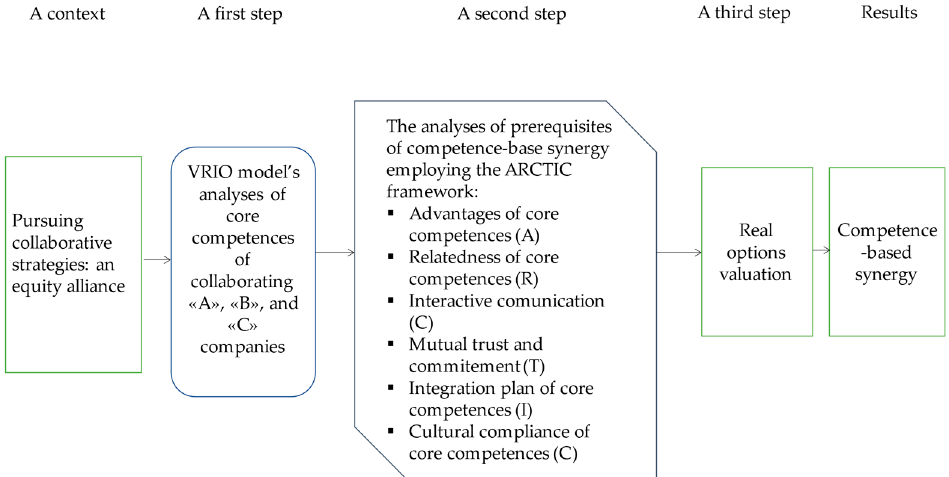
Figure 1. The conceptual model of the research.